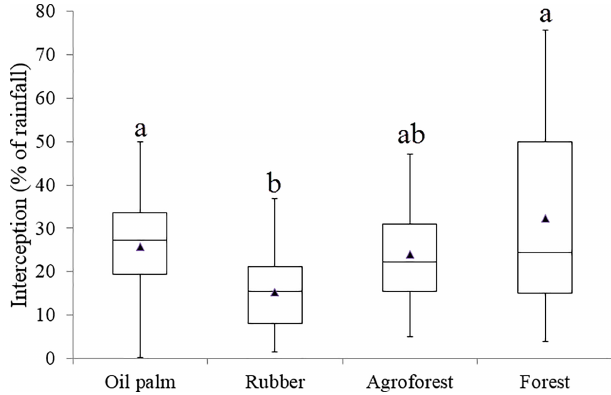
Figure 2. Canopy interception of rainfall under different land uses. Different letters indicate significant differences between the means (Bonferroni-corrected post hoc t -test based on analysis of variance (ANOVA); p